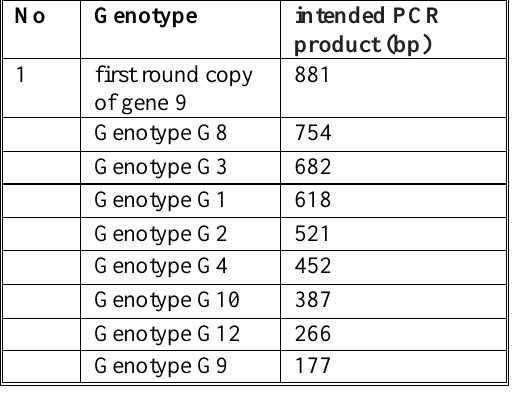
Table 6.The PCR primer sequence .